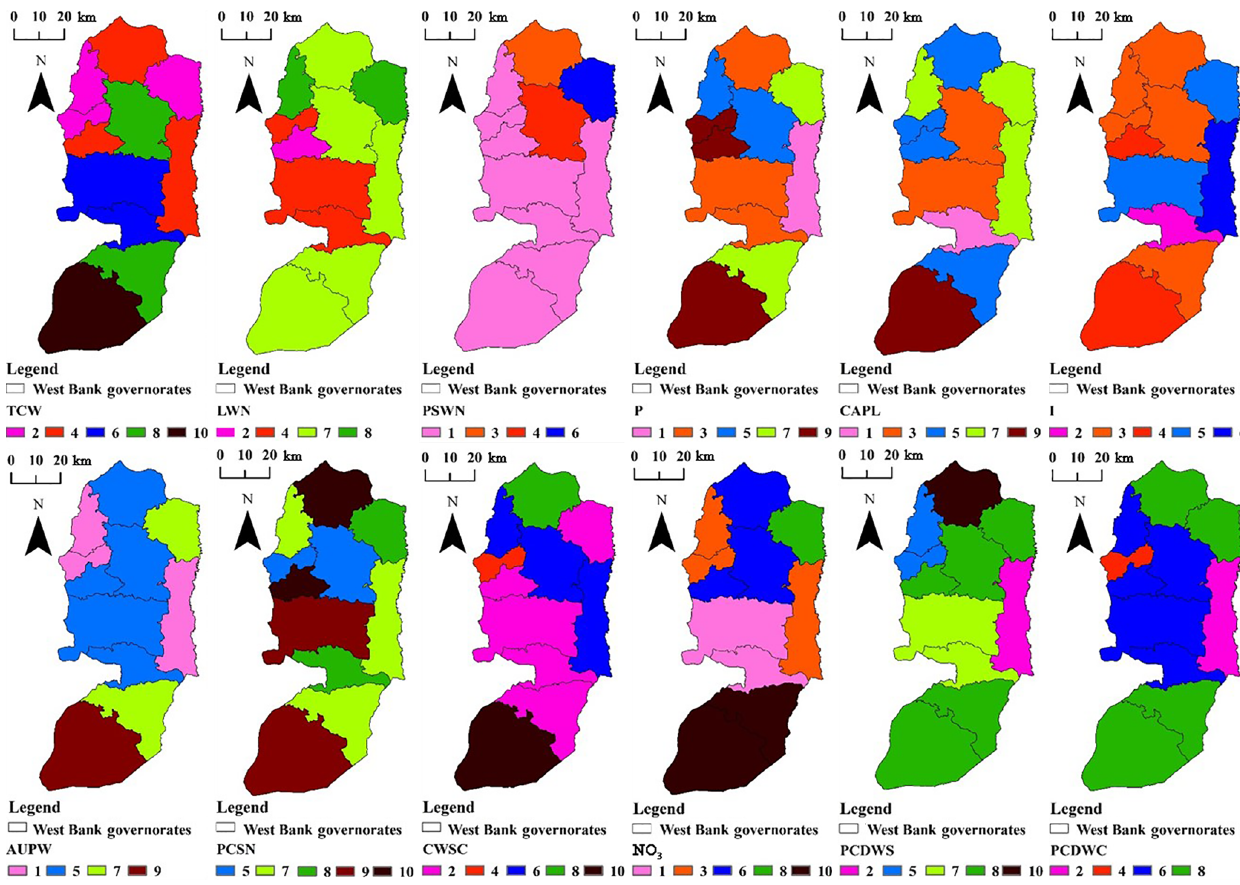
Figure 3. The score rasters of the 12 DWP criteria for the West Bank.